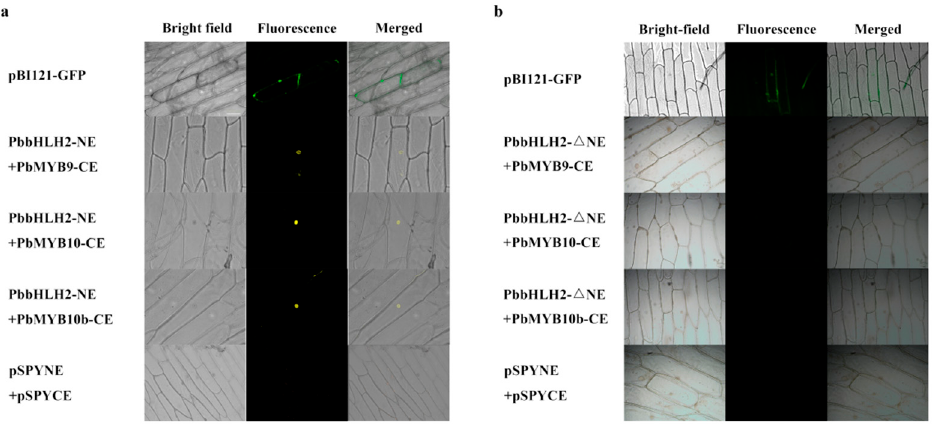
Figure 5. The interaction of PbbHLH2 and PbMYBs in onion epidermal cell. ( a , b ) The interaction of PbbHLH2 ( a ) and PbbHLH2- △ NE, having a delete MIR-domain, ( b ) with PbMYB9, 10, and 10b in onion epidermal cells. The BiFC was observed using a fluorescence microscope (Axio Observer D1, Carl Zeiss Jena, Oberkochen, Germany).